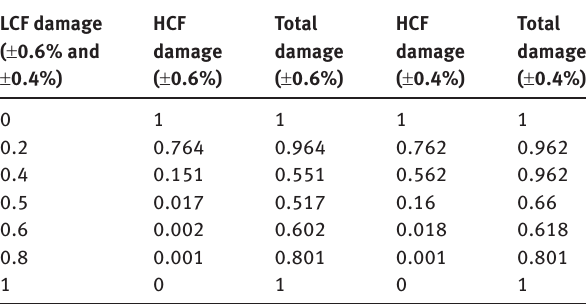
Table 1: LCF, HCF and total damage summation for pre-cycling at different strain amplitudes ( ± 0.6% and ± 0.4%), 923